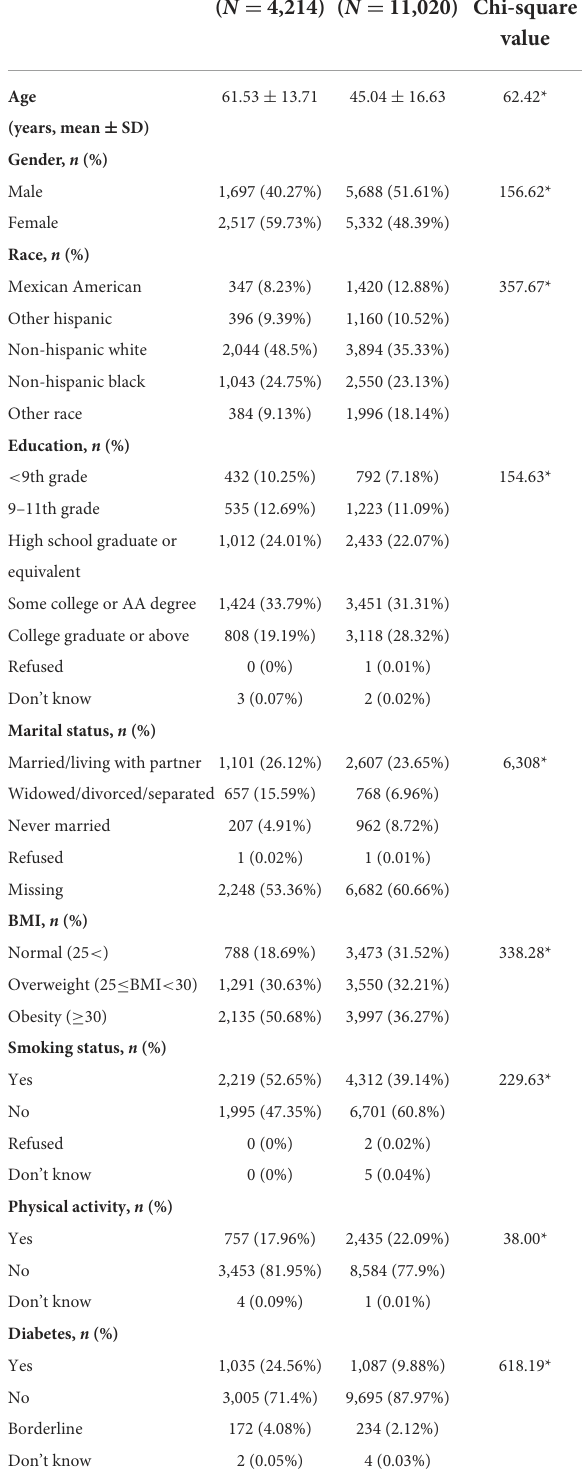
TABLE 1 Characteristics of participants by osteoarthritis status in American aging people from NHANES 2011-2020.